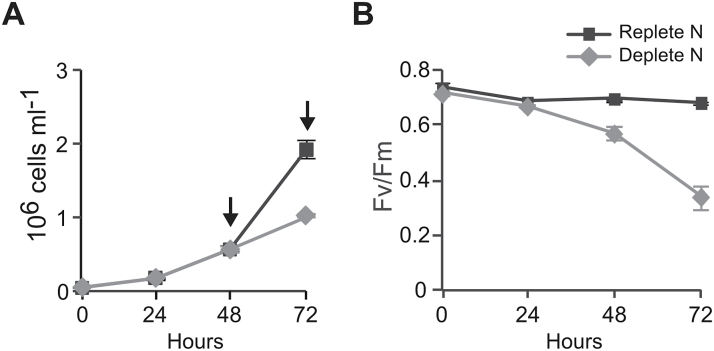
Physiological responses of P. tricornutum to nitrate deprivation. Growth curves (A) and changes in maximum quantum yield (Fv/Fm) (B) of P. tricornutum in N-replete (f/2 medium) and N-deprived (f/2 medium minus nitrate) cultures. Arrows indicate sampling time points. Values are means±standard deviation of four biological replicates.